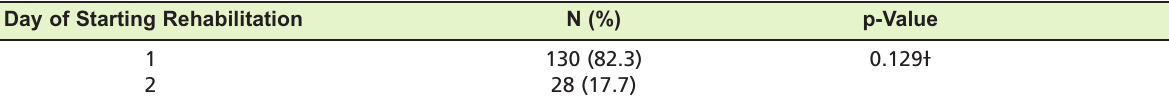
Day the patients began rehabilitation post-operative (Day 0 operation Table II: